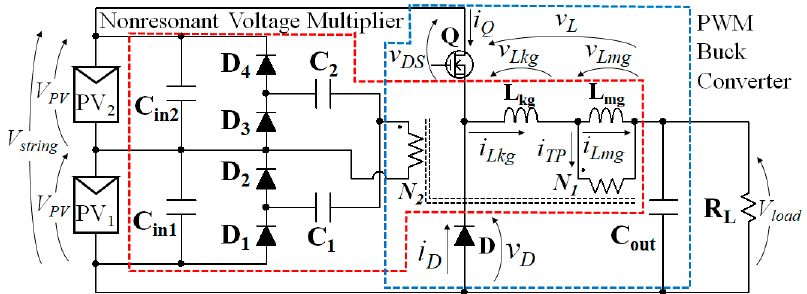
Figure 8. Proposed single-switch single-magnetic PWM converter integrating non-resonant voltage multiplier (NRVM).